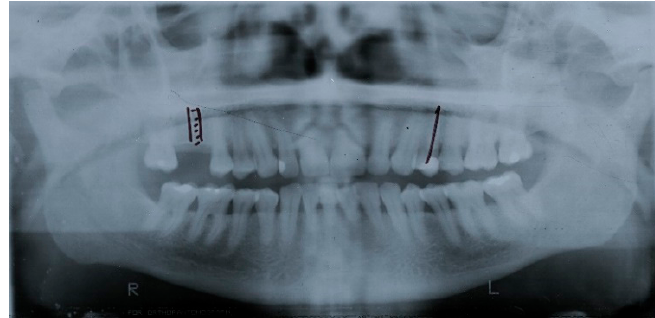
Figure 3. Prediagnosis orthopantomography of a female patient with 70 years of age at baseline. Table 4. Patient profiling using the risk score at the baseline appointment. According to the clinical evaluation, the presence of gingivitis, subgingival calculus and history of periodontitis were noted, scoring an overall 4 points for a high risk of periodontitis.